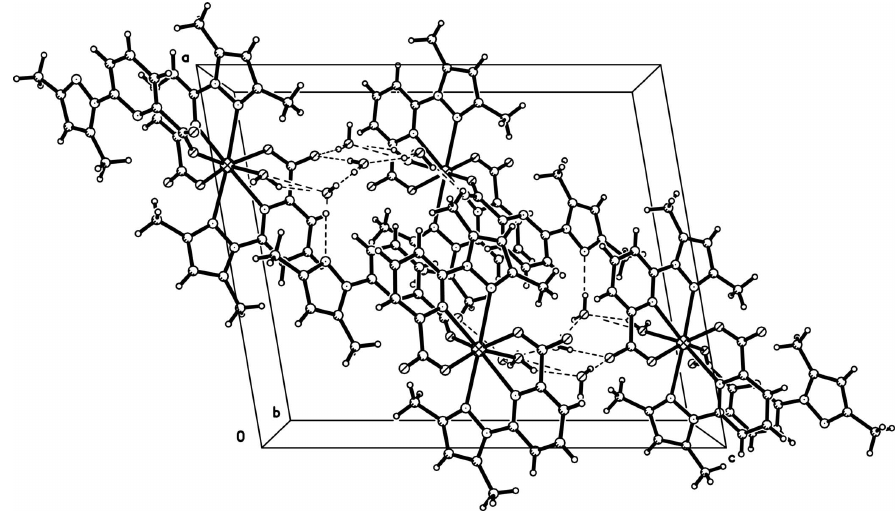
Figure 2 Crystal packing of the title compound showing the hydrogen bonding interactions as dashed